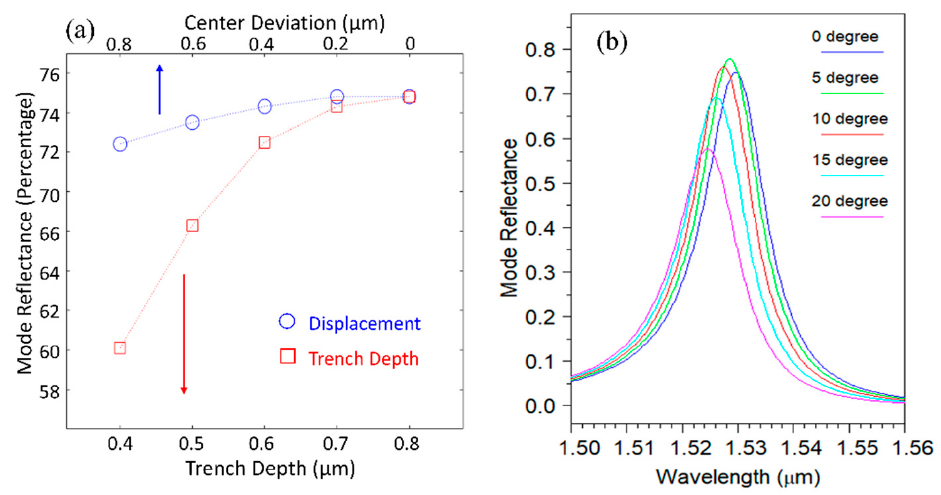
Figure 5. ( a ) Mode reflectance for the designed fiber-tip RWG for different off-center x-axis alignment errors (blue, circles) and for different depths of the mirrors’ trenches (red, squares); ( b ) Mode reflectance for different inclinations α of the sidewalls of the mirrors’ trenches.